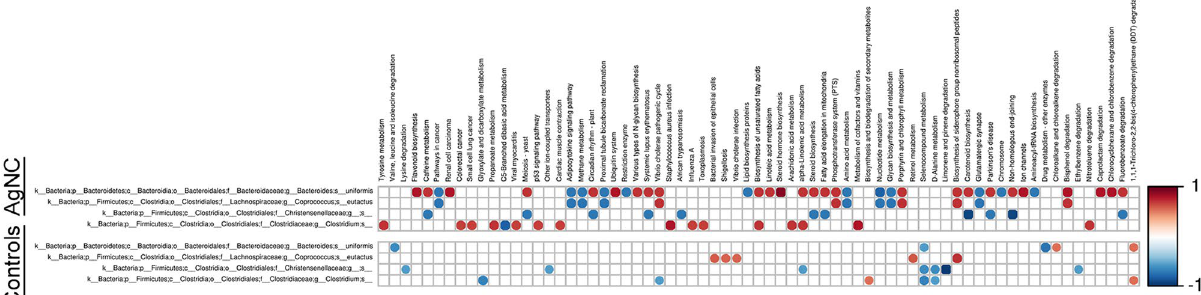
Figure 9. Bacterial metabolic and other pathway differences in the fecal samples of AgNC-treated individuals vs. controls. As described in Fig. 7 of previously published article 80 and in the Materials and Methods section, correlations between the PICRUSt-generated functional profile and QIIME-generated genus level bacterial abundance were calculated and plotted against treatment. Those genera with a LEfSe LDA score ≥ 2 between controls and BPA individuals are depicted. Metabolic pathway designations are delineated at the bottom of the figure. Shading intensity and size of the circles indicates the Kendall rank correlation coefficient between matrices. Orange/red indicates a positive correlation; whereas blue designates a negative correlationat a p value ≤ 0.05.